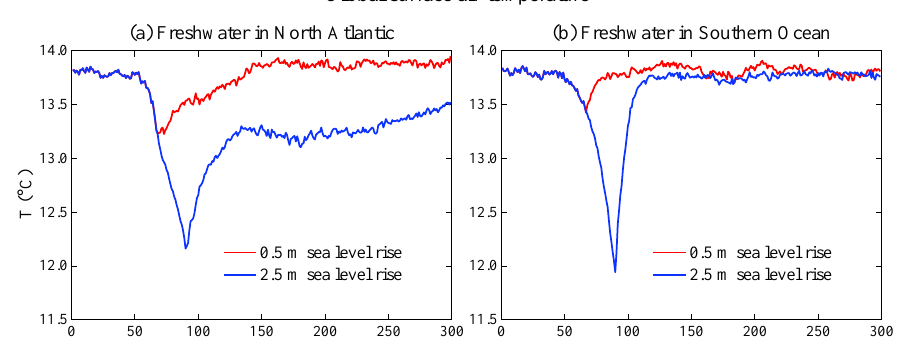
Figure 11. Ensemble-mean global surface air temperature ( ◦ C) for experiments (years on x axis) with freshwater forcing in either the North Atlantic Ocean (left) or the Southern Ocean (right).